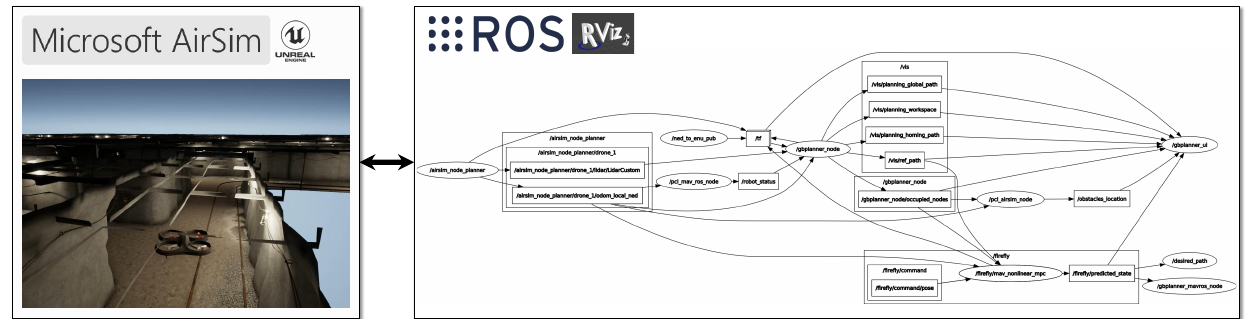
Figure 9. Simulation Architecture.